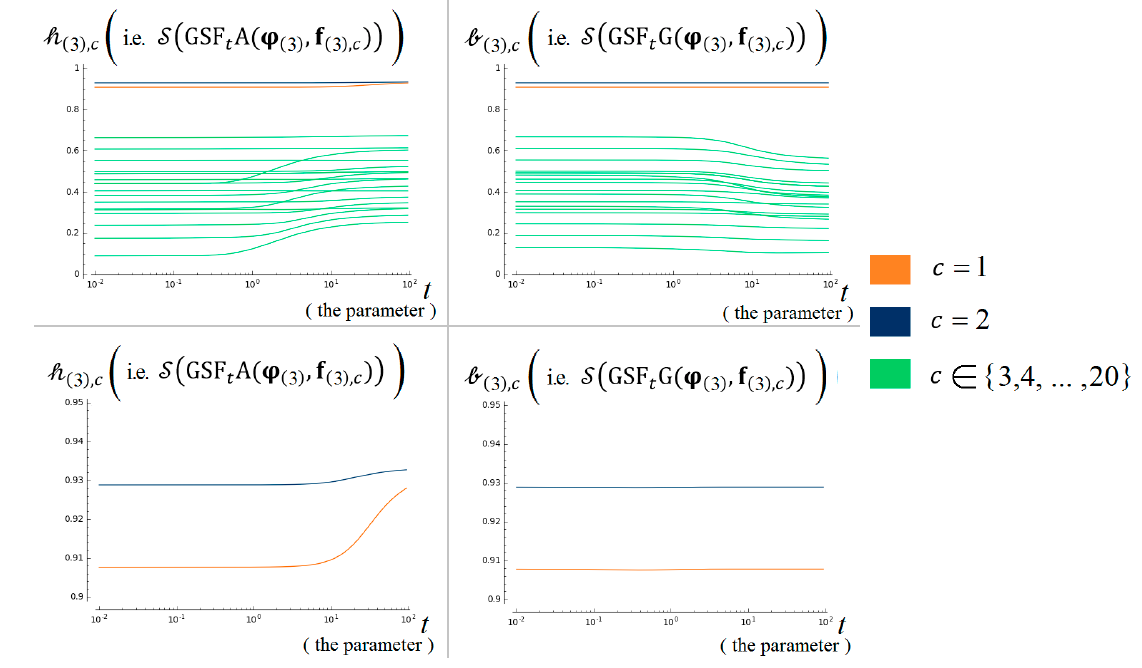
Figure 6. The results of our algorithms GSF (cid:3047) A and GSF (cid:3047) A for compliance of Test 3